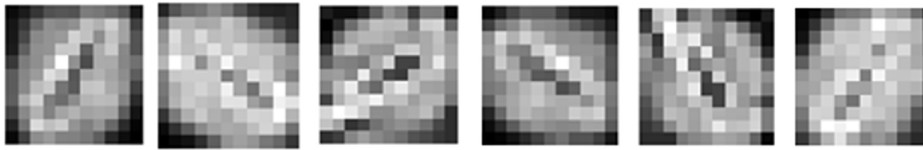
Figure 3. Diagram of six templates with different directions in the convolution module.